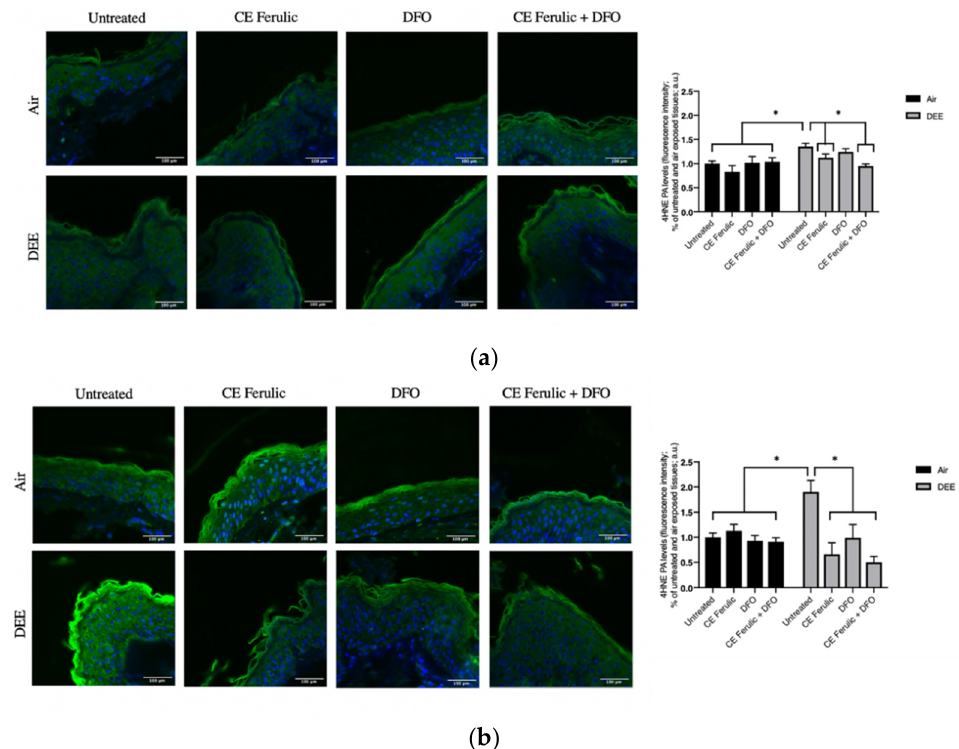
Figure 1. Skin exposure to DEE increases lipid peroxidation related damage, while topical application of CE Ferulic and its combination with DFO can prevent this effect. Levels of 4HNE PA in ex vivo human skin explants untreated or pretreated with the cosmeceutical formulation mixture and DFO, alone or in combination, and exposed to air or DEE at Day 1 ( a ) and Day 4 ( b ). Green fluorescence staining represents 4HNE PA immunoreactivity, while cell nuclei are stained in blue with DAPI. Original magnification 40×. On the right, semi-quantification of the immunofluorescence intensities performed by ImageJ are shown in the histograms. Data are expressed as arbitrary units (averages of three independent experiments), * p ≤ 0.05, by ANOVA. Scale bar = 100 μ m.